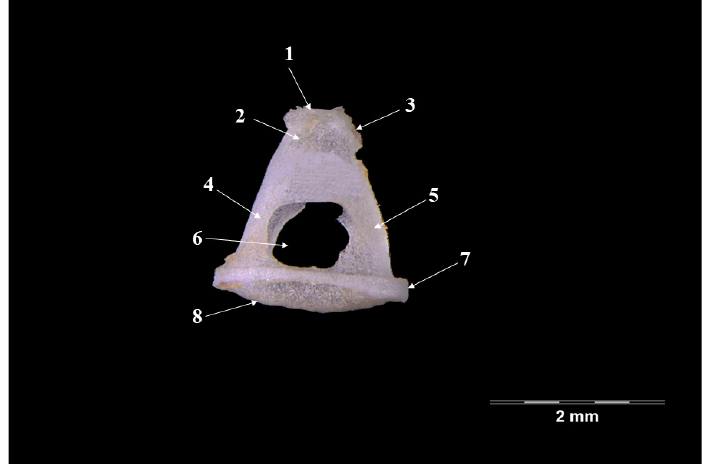
Figure 5. Stapes-Ventral pespective. 1. Articulatio incundomallearis; 2. Caput stapedis; 3. Tuberosi- tas m.stapedius; 4. Crus rostrale; 5. Crus caudale; 6. Intercrural foramen; 7. Basis stapedis; 8. Facies interna basis stepedis.